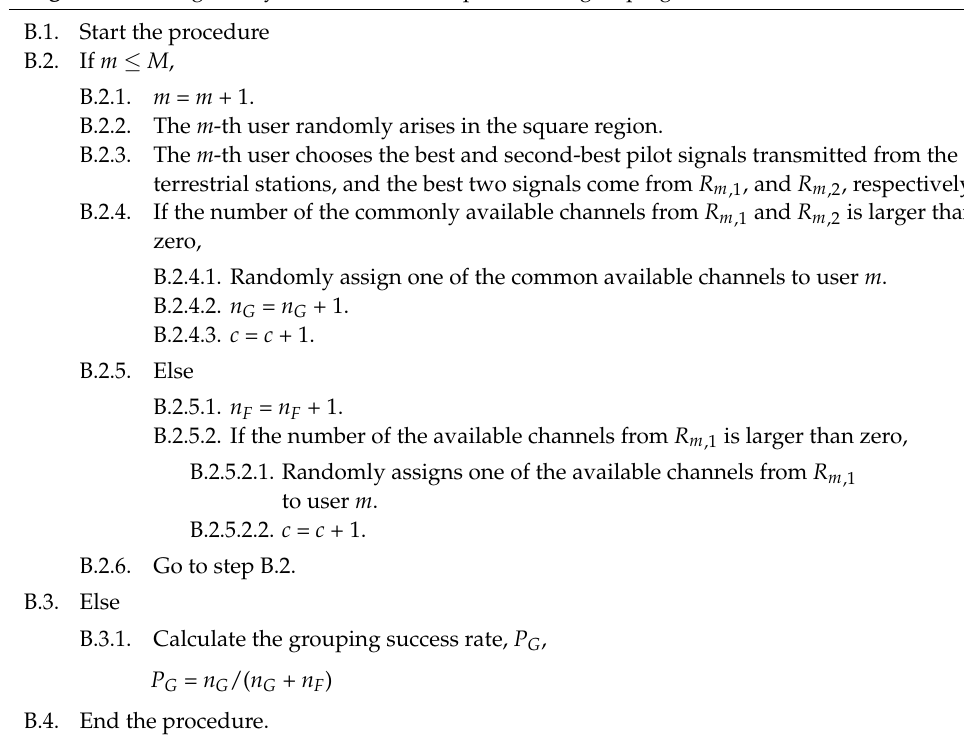
Algorithm 3: Single relay allowed modified pilot-based grouping